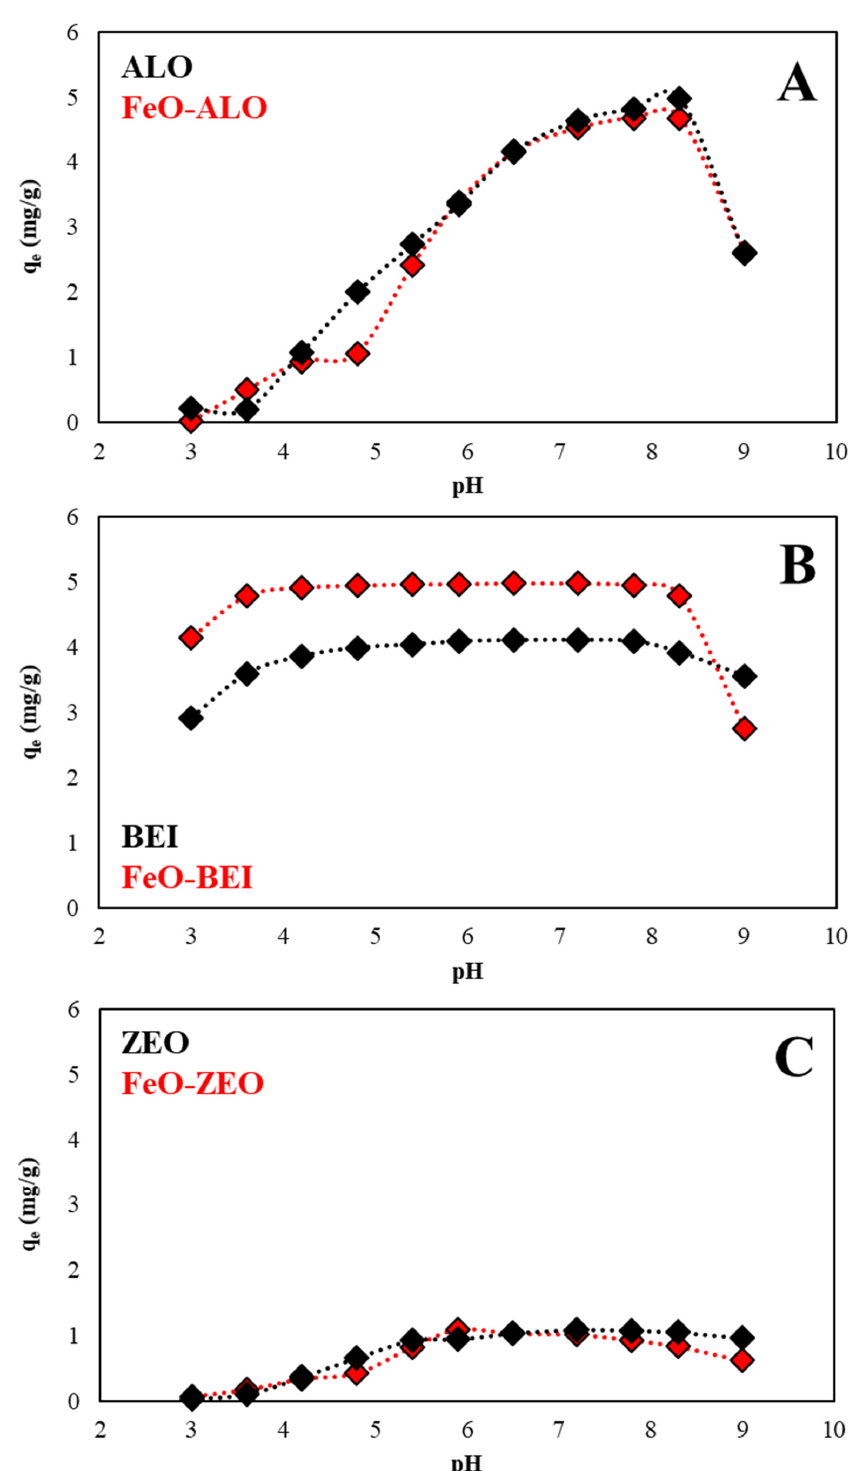
Figure 6. pH-drift experiments (operational conditions: 298 K, adsorbate/adsorbent ratio: 500:1, 10 mg/L Ba). The effect of solution pH on the adsorption of aqueous Ba 2+ by natural and FeO-modified ALO ( A ), BEI ( B ) and ZEO ( C ) is shown.